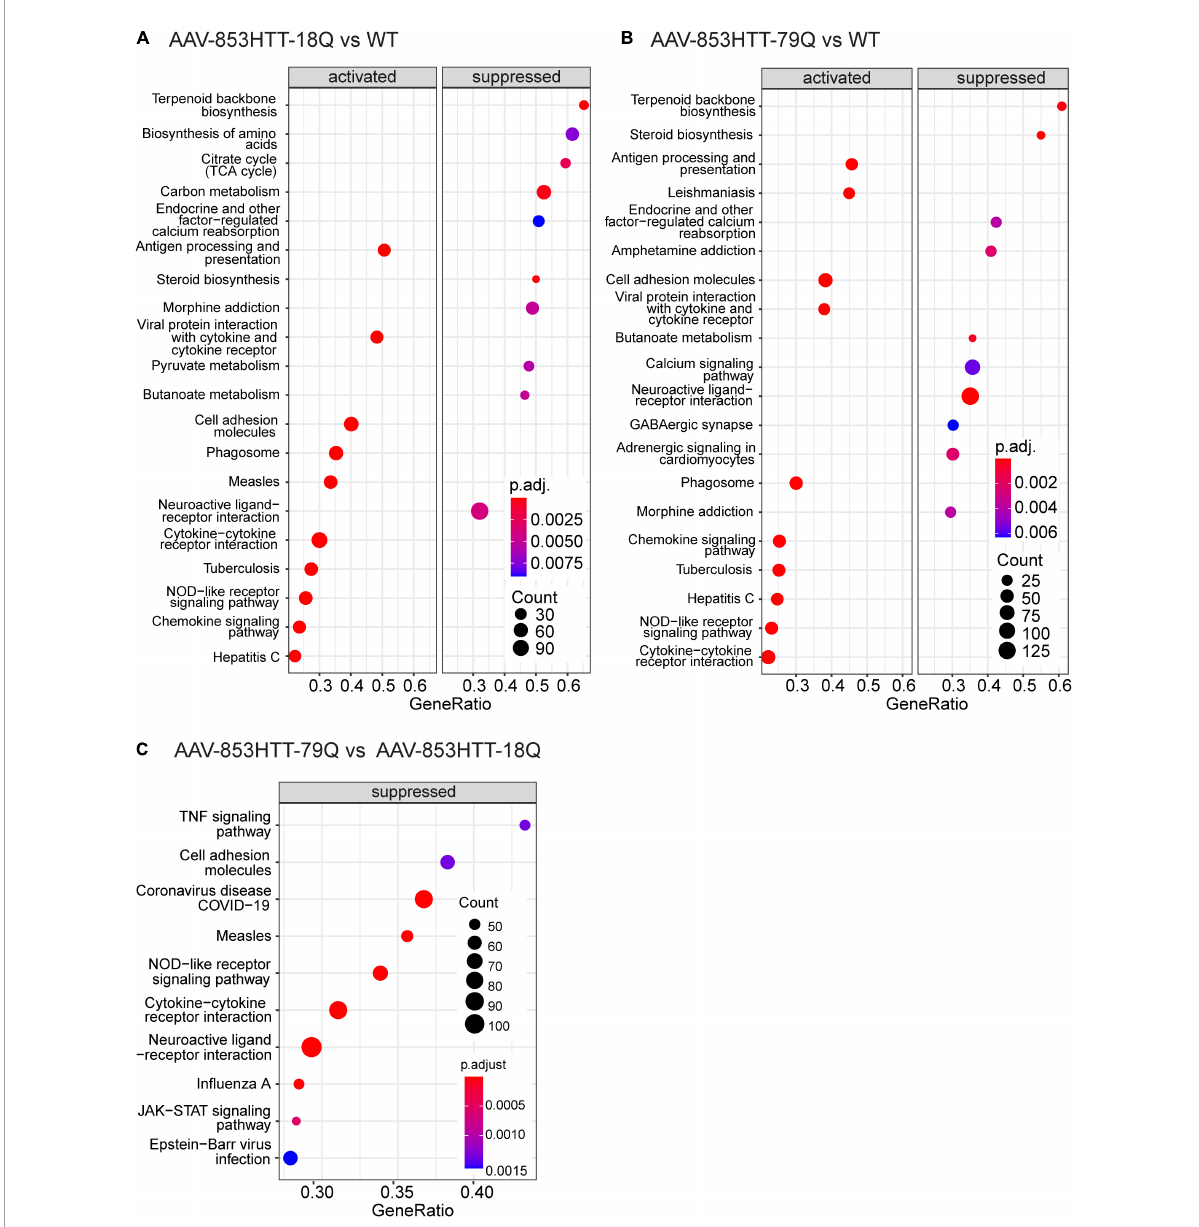
FIGURE4 Gene set enrichment analysis (GSEA) of KEGG pathways comparing mutant huntingtin (mHTT) 79Q to wild-type huntingtin (wtHTT) 18Q indicate suppressed pathways related to the immune system and neuroendocrine signaling. GSEA of KEGG pathways was performed on the limma output files for the AAV datasets (79Q vs. 18Q, 18Q vs. WT and 79Q vs. WT). (A) The top 10 up- and top 10 downregulated KEGG pathways in AAV-853HTT-18Q vs. WT and (B) AAV-853HTT-79Q vs. WT. (C) For AAV-853HTT-79Q vs. AAV-853HTT-18Q, all pathways identified by GSEA-KEGG had a negative normalized enrichment score (NES), indicating suppression. The top 10 are shown. AAV, adeno-associated viral vector; 79Q, HTT853-79Q vector; 18Q, HTT853-18Q